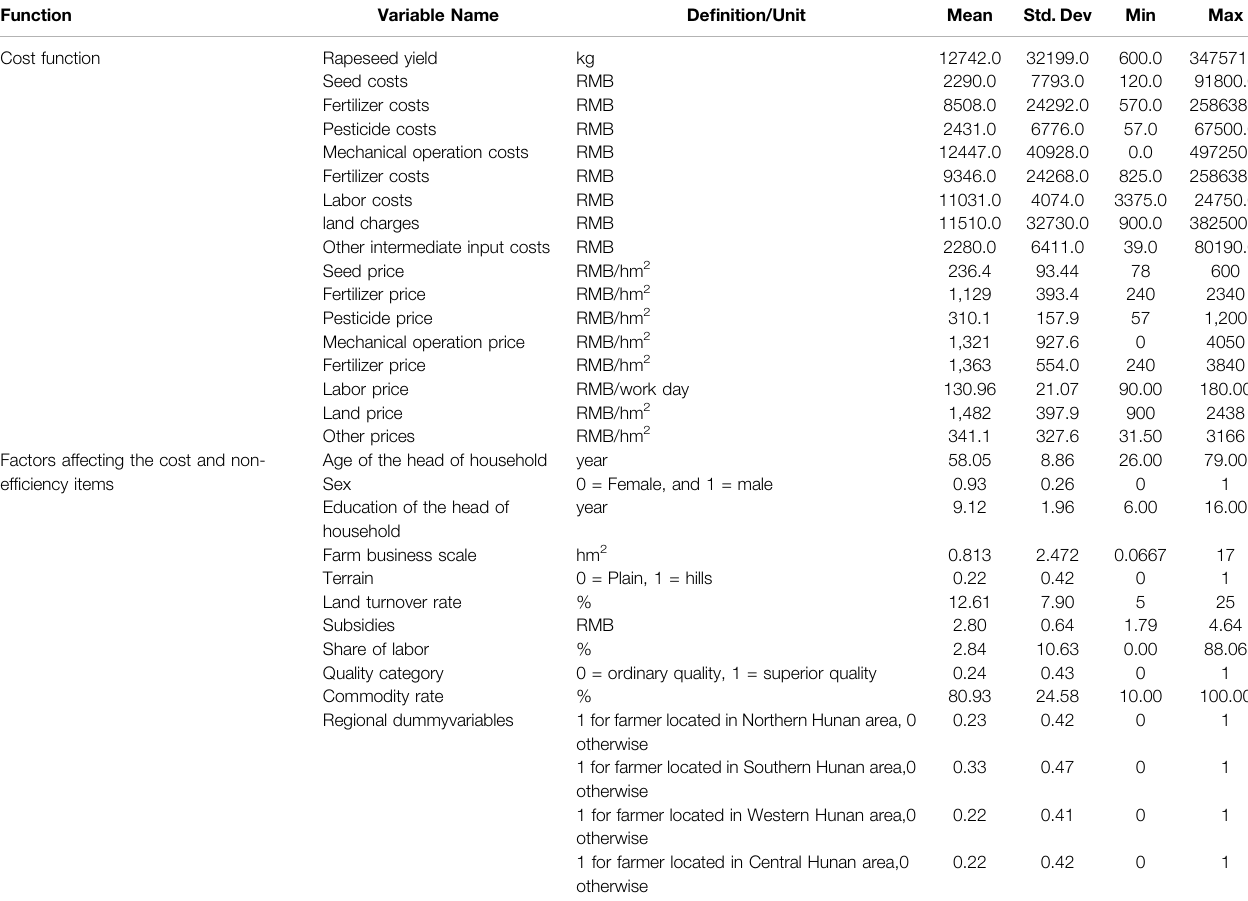
TABLE 1 | Variable de fi nitions and descriptive statistics.